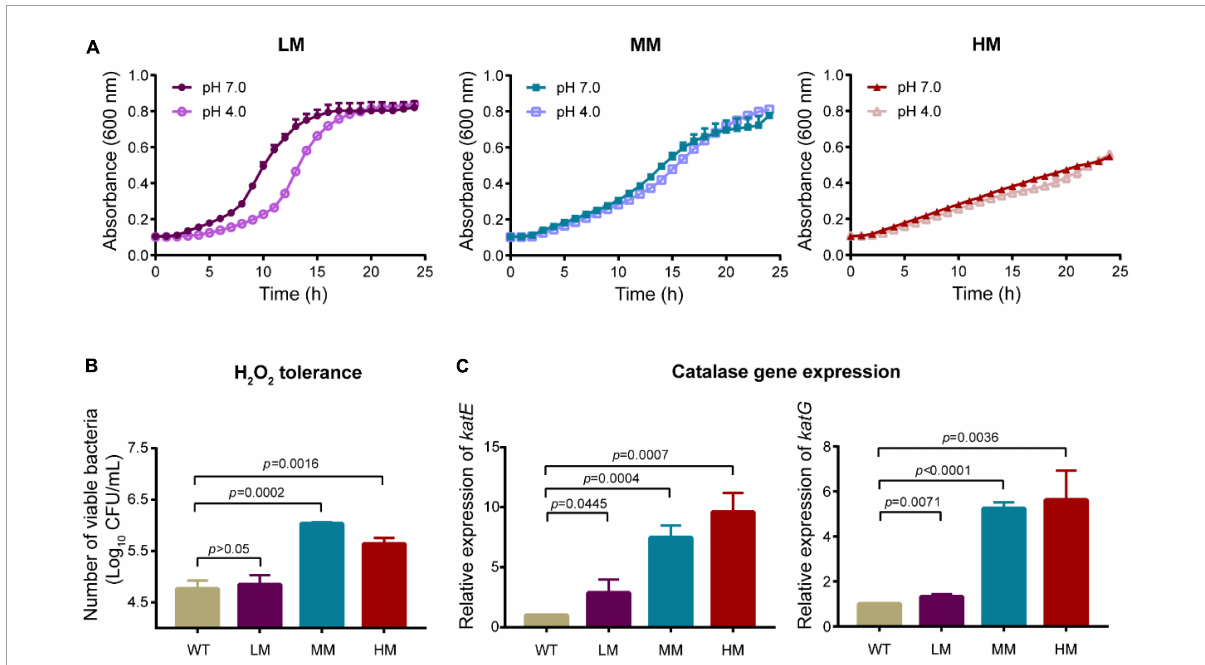
FIGURE2 Mucoid A. baumannii shows tolerance to acid and hydrogen peroxide. (A) Growth dynamics of A. baumannii LM, MM, and HM strains under different pH conditions for 24 h. (B) H 2 O 2 tolerance of A. baumannii LM, MM, and HM strains. A. baumannii strains were treated with 50 mmol/L H 2 O 2 for 30 min. WT: A. baumannii ATCC 19606. (C) The mRNA expression of catalase genes katE and katG in WT and mucoid A. baumannii isolates. All experiments were performed as three biologically independent experiments, and the mean ± SD was shown. P values were determined using an unpaired, two-tailed Student’s t